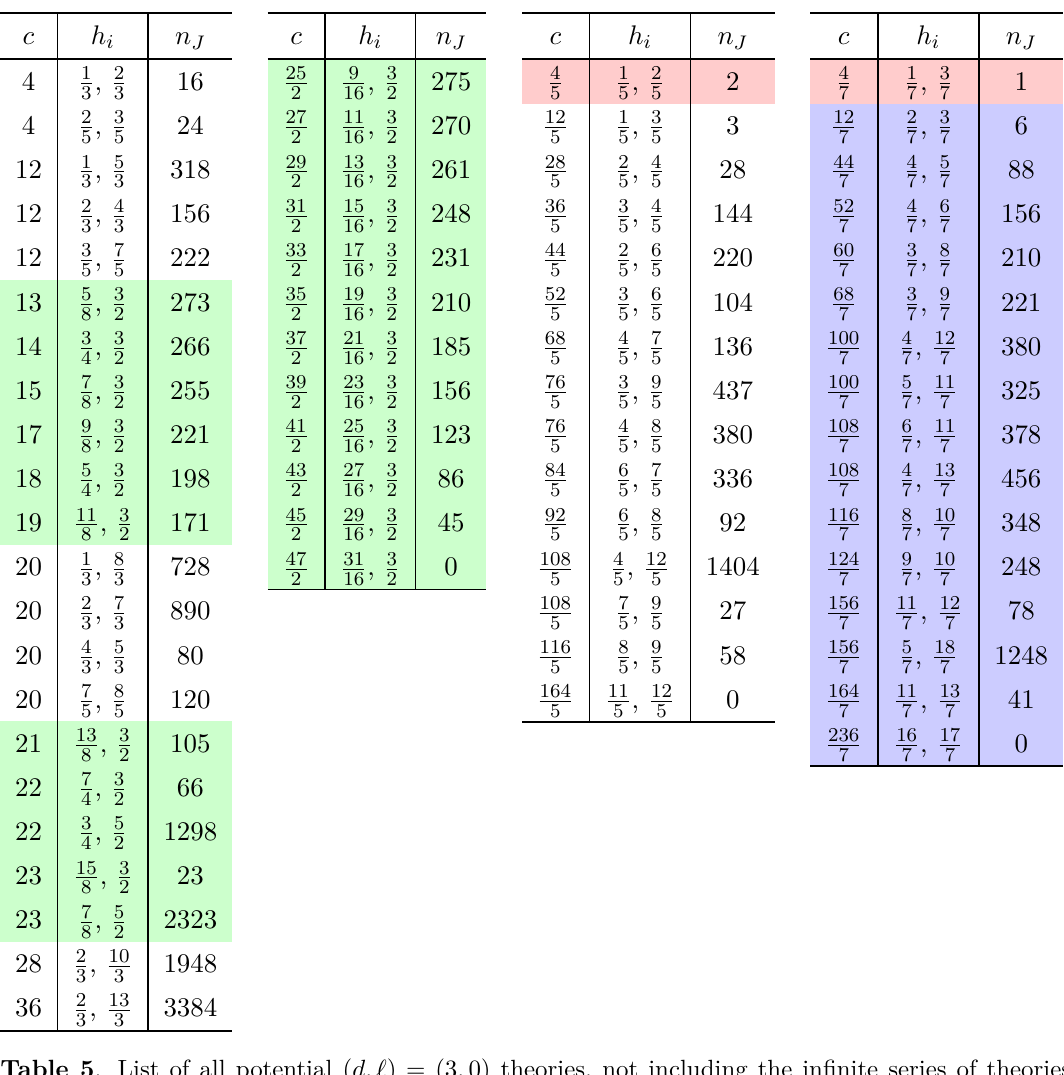
gives the number of spin-1 currents in that J